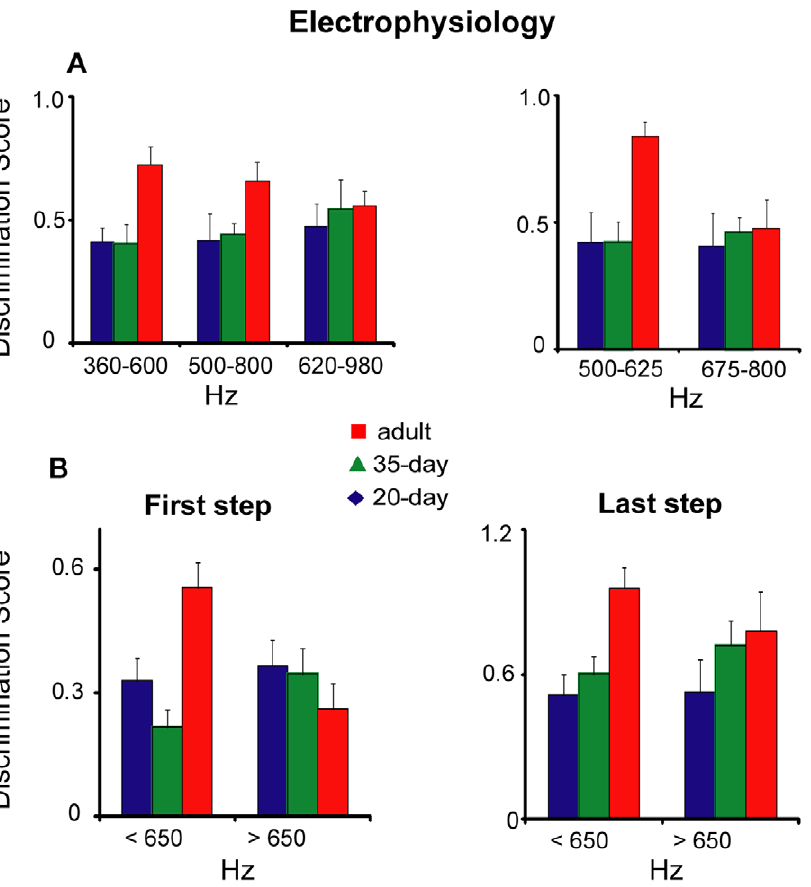
Figure 4. Neural discrimination gradients as a function of age and frequency range. (A) Discrimination scores averaged across all frequencies within each frequency range (left panel) and separately for test stimuli below versus above the habituating stimulus for the experiment in which birds were habituated to a call of 650 Hz and tested with calls from 500–800 Hz. (B) Discrimination scores at the first and last frequency steps within the high (675–800 Hz) versus low (500–625 Hz) frequency ranges. All scores plotted as mean 6 SEM.